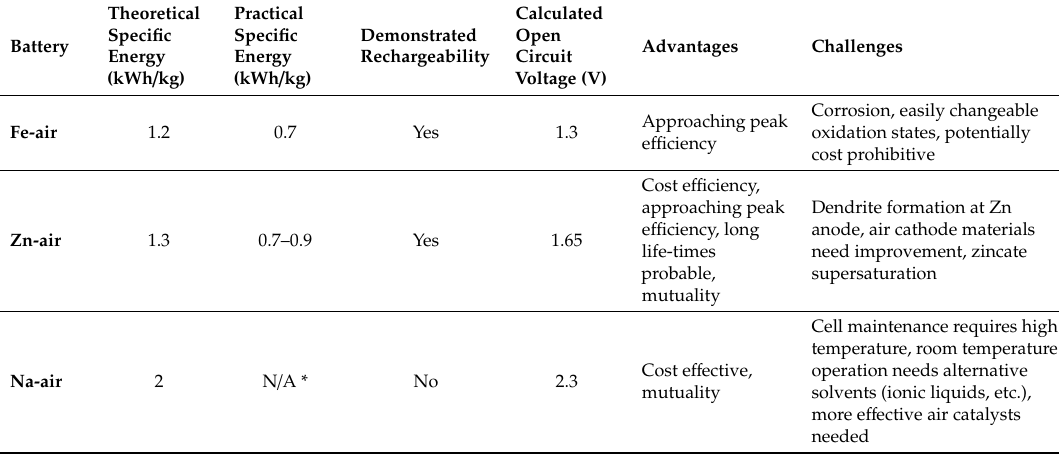
Table 9. A comparison among di ff erent types of metal –air batteries